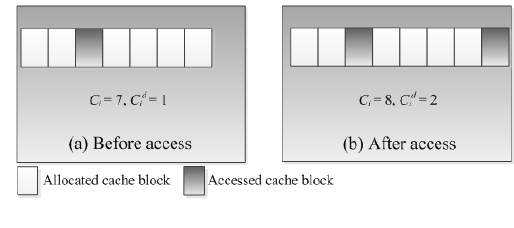
Fig. 4. An example of counter manipulation for VM i